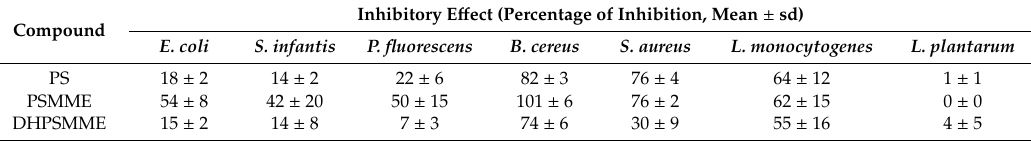
Table 4. Antibacterial activity of pinosylvins from Välimaa et al. (2007) [42].